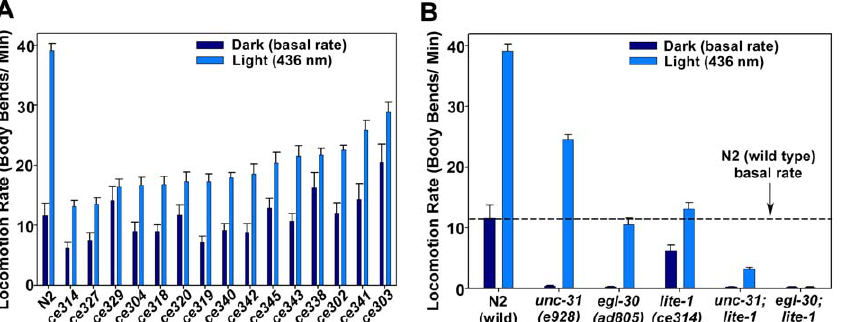
Figure 6. LITE-1 Mutations Strongly Reduce the Light Response and the Light-Driven Rescue of Synaptic Signaling Mutants (A) The strongest lite-1 mutants, which are likely nulls, still have a residual response to light. Shown are the mean locomotion rates of wild type and the 15 unique lite-1 mutants in low power white light (dark bars) or blue-violet light that maximizes the wild-type response (730 l W/ mm 2 ;light bars). Error bars are the standard errors in populations of ten animals. (B) LITE-1 is required for light-driven rescue of synaptic signaling mutants. Shown are the mean locomotion rates of each strain during a 6-min exposure to low power white light (dark bars) or to an optimal power of blue-violet light (730 l W/mm 2 for N2 and lite-1(ce314) and 1460 l W/mm 2 for unc-31 and egl-30 single and double mutants). Error bars are the standard errors in populations of ten animals.